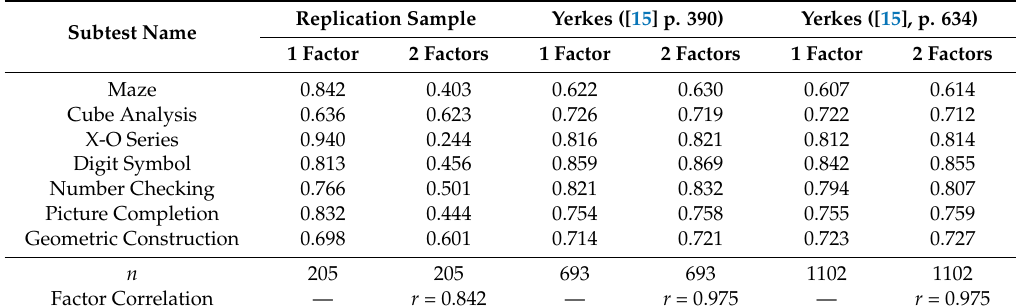
Table 5. Standardized Factor Loadings, Factor Correlation, and Percentage of Variance Explained by Factors for Army Beta